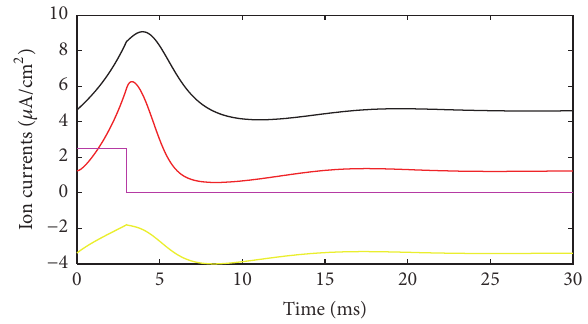
Figure 9: Ratio of total power and stimulus power (suprathreshold).